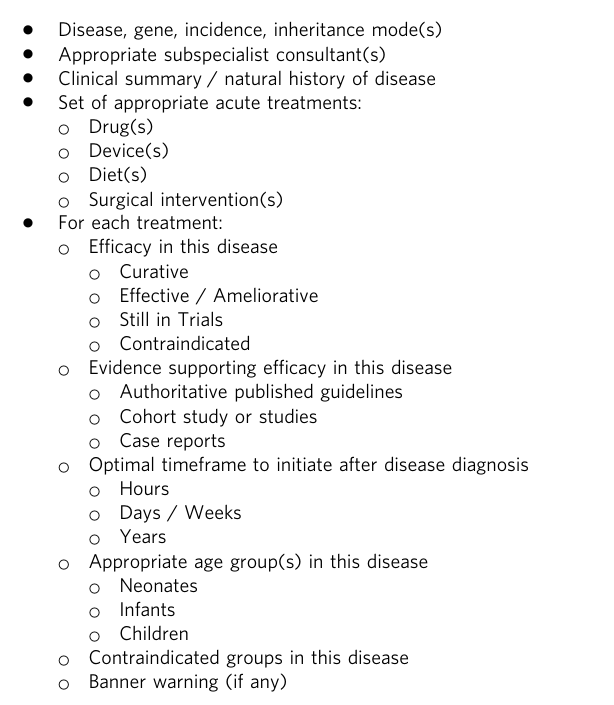
Box 1 | Minimal, structured data elements required